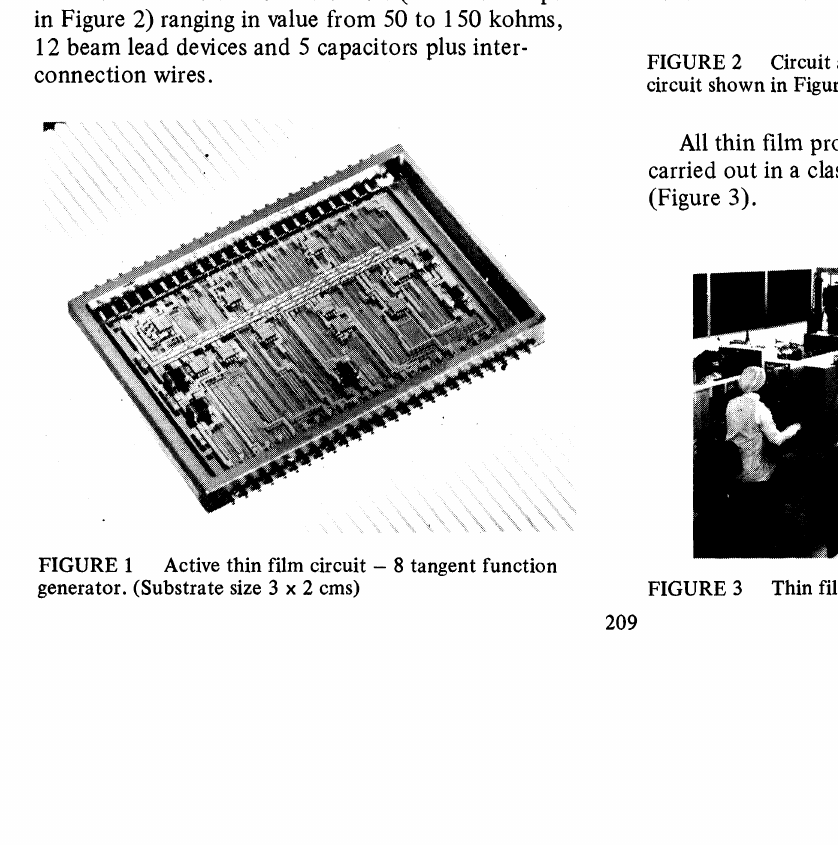
FIGURE 3 Thin film processing 209